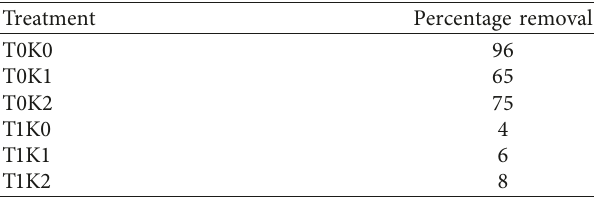
Table 5: Efficiency of Zn weight loss by sunflower plants.